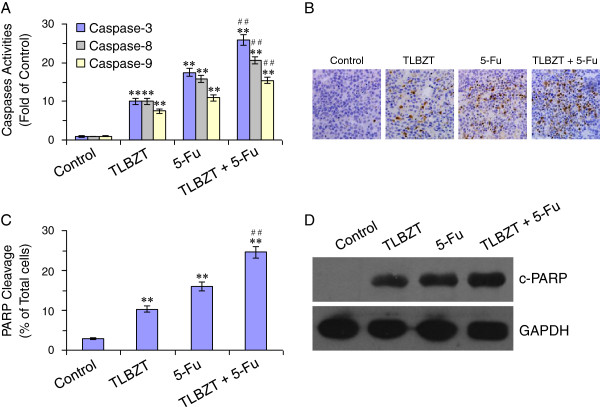
TLBZT and 5-FU activitied Caspases. After three weeks treatment, CT26 carcinomas (3 tumors/group) were removed, homogenized, and subjected to Caspase-3, Caspase-8 and Caspase-9 activities assay by cleavage of specific substrate. Caspases activities were expressed as fold activation over control (A). Cleavage of PARP was detected by immunohistochemistry (3 tumors/group) and observed under microscope (×200) (B). Cleaved PARP positive cells (3 HPF/slide) were counted by Image-Pro Plus 6.0 software and expressed as percentage of total cells (C). D, PARP Cleavage in CT26 carcinomas were further verified with western blot by antibody against cleavage PARP (c-PARP). GAPDH was used as a loading control. **P<0.01, versus control group, ##P<0.01, versus TLBZT or 5-Fu group.